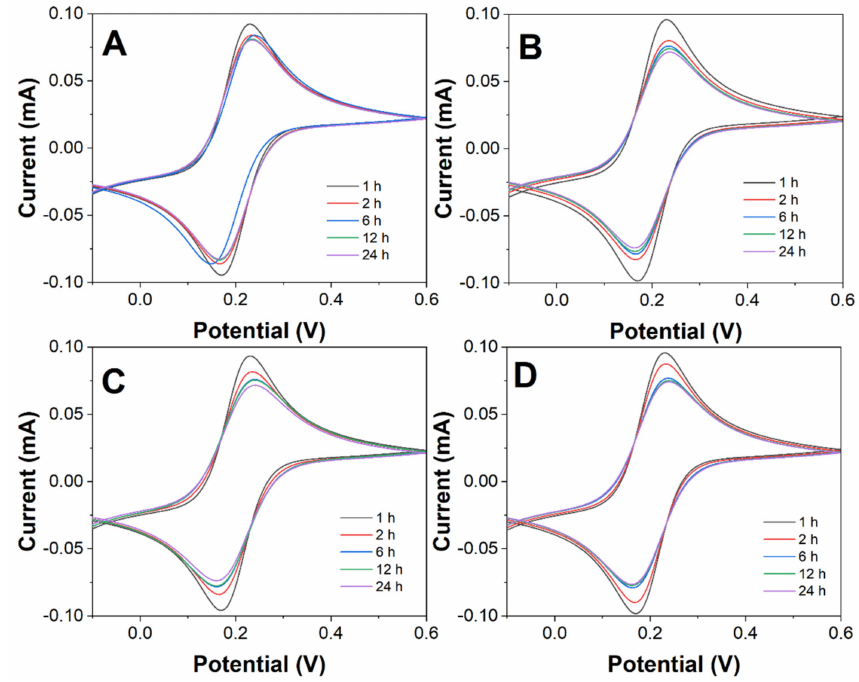
Figure 1. CV curves of MPA/ME/Au with MPA volume percentage of ( A ) 100%, ( B ) 50%, ( C ) 25%, and ( D ) 10%. Scan rate: 50